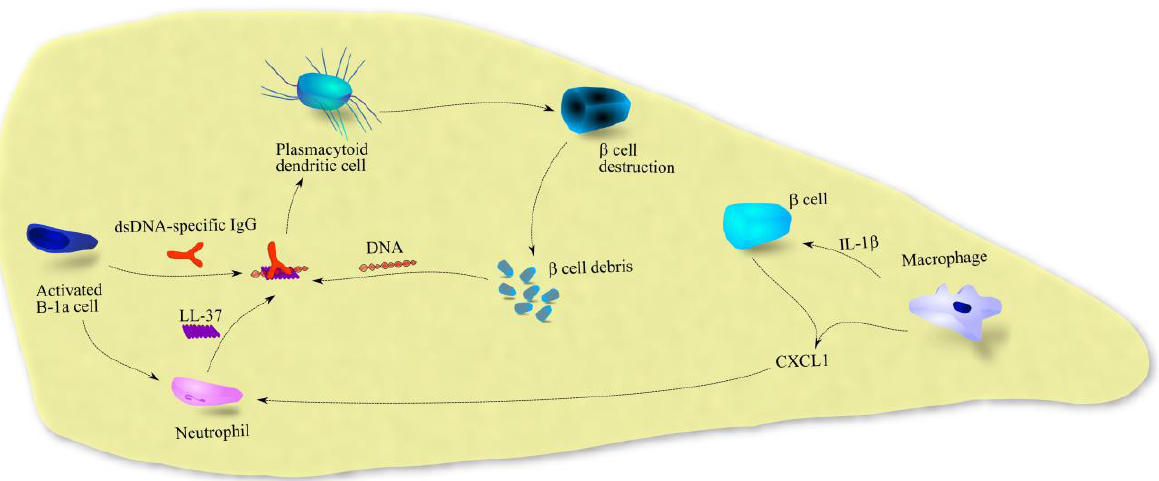
Figure 4. The importance of CXCL1 in T1DM. In patients with T1DM, during inflammatory reactions in the pancreas, CXCL1 expression is increased in macrophages and influenced by IL-1 β in β cells. This chemokine causes the recruitment of neutrophils to the pancreas. In this organ, neutrophils under the influence of activated B-1a cells secrete LL-37. This peptide with dsDNA and dsDNA-specific IgG forms a complex that activates plasmacytoid dendritic cells (pDC), which initiates the destruction of pancreatic islets. Abbreviations: CXCL1—CXC motif chemokine ligand 1; IL-1 β —interleukin-1 β . Source: own